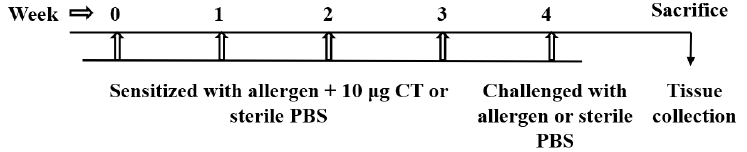
Figure 1. Schedule of sensitization and challenge experiment of BALB/c mice.